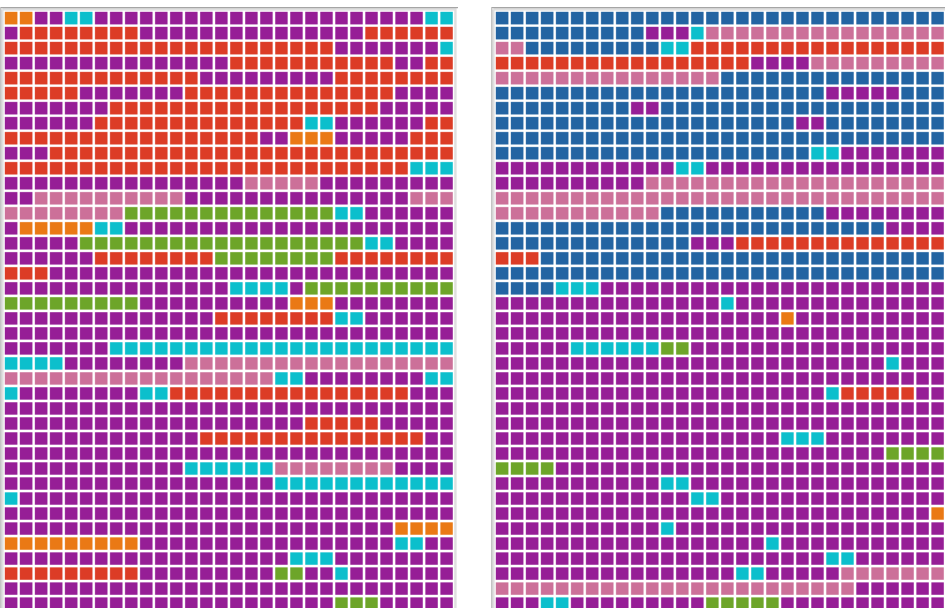
Figure 3. Document portraits of P1–F2F diagnostics ( left ) and telediagnostics ( right ) showing the sequence of codings for the selected document weighted by the length of the segments. Colours of the code system are purple (verbal), pink (expression of excessive demand), red (nonverbal), orange (perceptual), yellow (use of aids), green (executive functions), light blue (affective), and deep blue (aids of relatives).